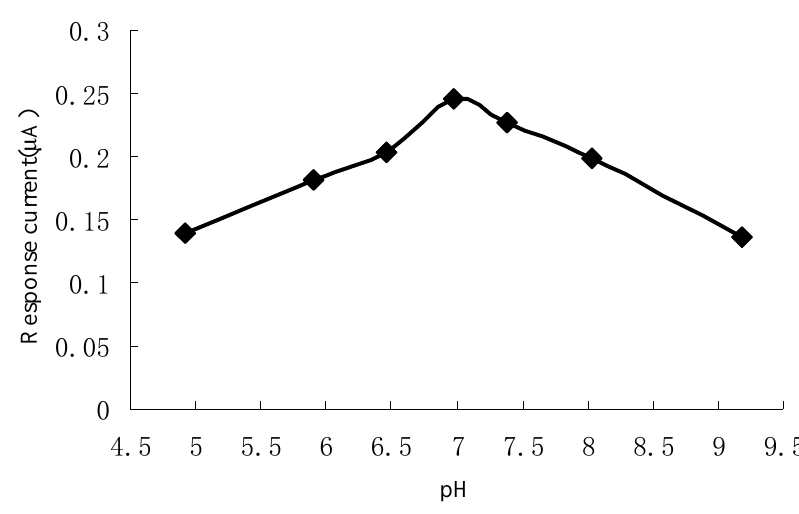
Figure 6. Effect of pH on response current to 1 mM H Phosphate (0.033, 0.067, 0.1, 0.2 M) was chosen to study the influence of electrolyte